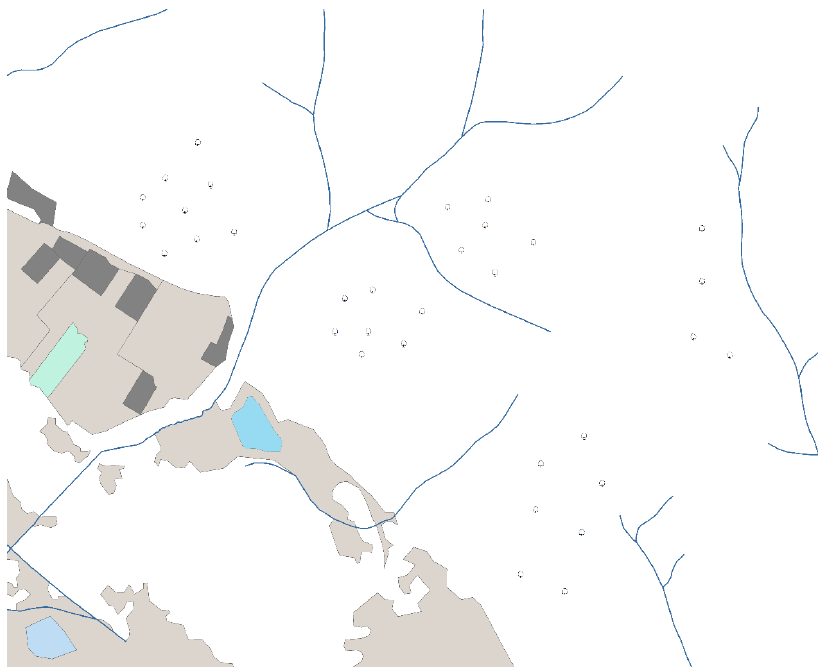
Figure 2. Point features (trees) represented with monochrome minimum dimensions. Points are shown in black on a white background.